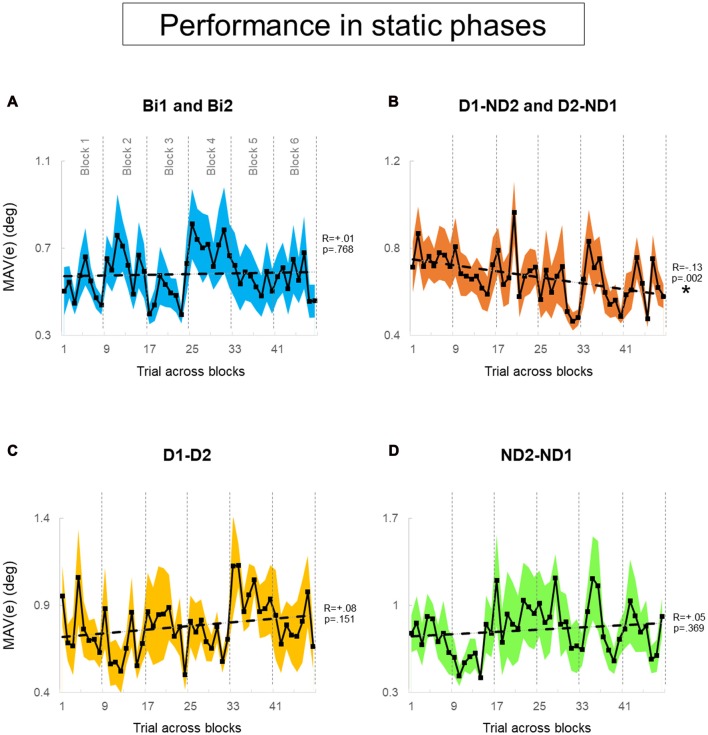
Performance error of static phase. (A–D) MAV(e) across trials and blocks for bimanual conditions, dominant and non-dominant hand conditions, both dominant hand condition and both non-dominant hand condition, respectively. There is six blocks and each block has eight trials. We tested 12 subjects and 12 pairs for each block in (A,B), respectively. We tested six dyads for each block in (C,D). Data are means averaged across all subjects or pairs. The shaded area around the main plot denote standard errors of the mean. The dash line plotted is the best fitted regression to test whether there is a significant trend for MAV(e) across trials and blocks. The asterisk denotes statistically significant relationship (correlation) between performance and trial (p < 0.05).